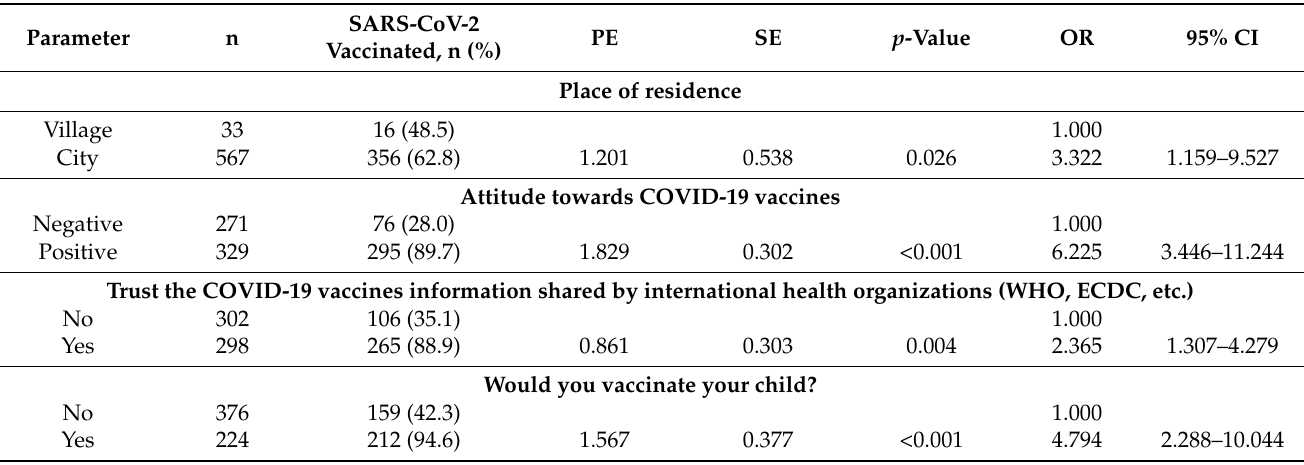
Table 5. Multivariable logistic regression showing the relationship between students vaccinated against SARS-CoV-2 infection and some